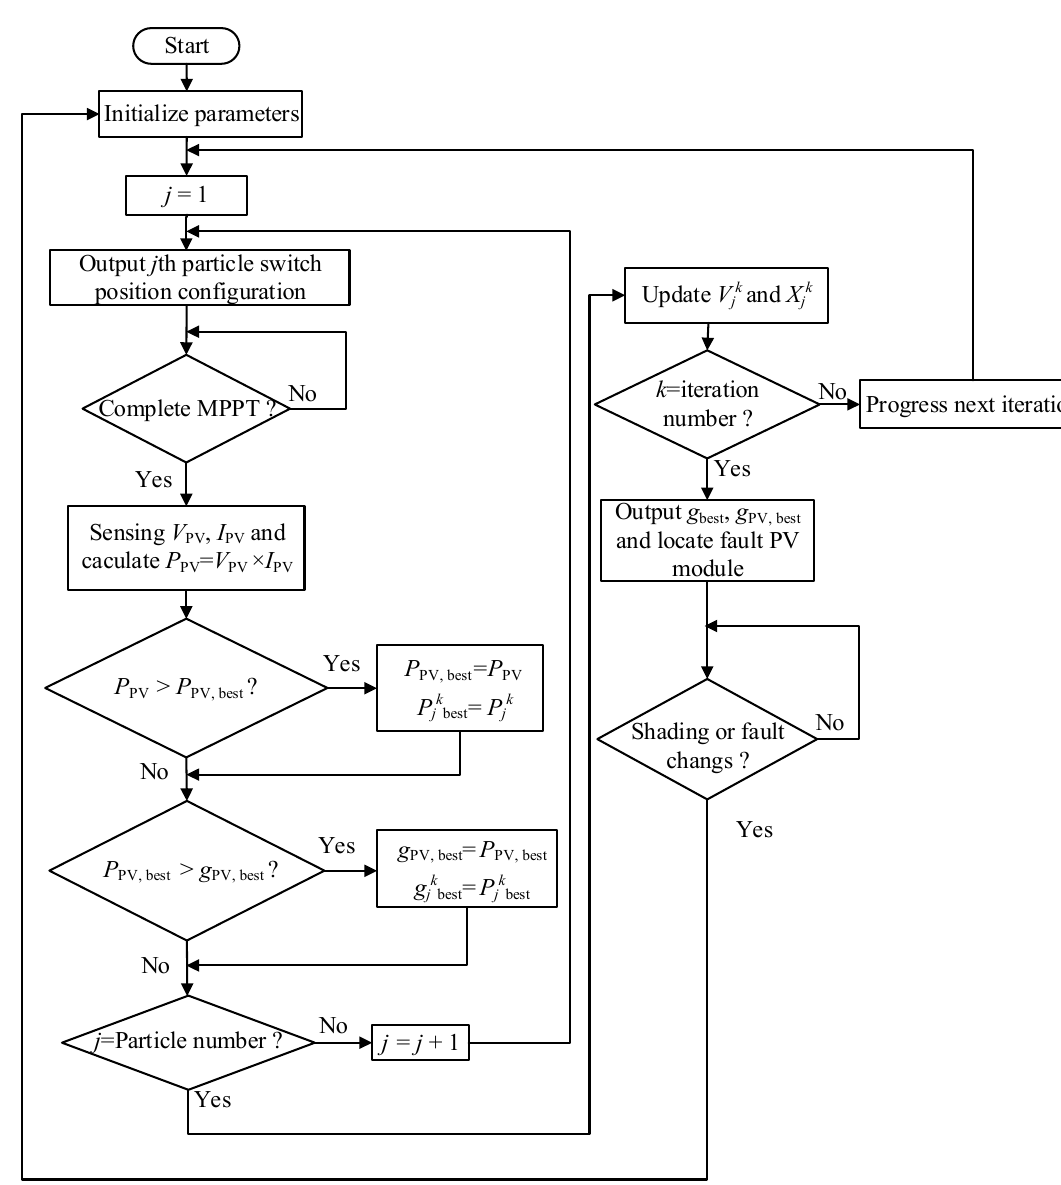
Figure 4. The flowchart of the configuration optimization using PSO for PV module array. In the algorithm of fault diagnosis, a particle represents the configuration of switch position in the Boolean variable. In Figure 1, the configuration of switch positions of S 2 , S 3 , S 6 , S 7 , S 10 , and S 11 is presented in Binary form 000000 ~ 111111. Therefore, there are 64 different switch position configurations. Here, 0 indicates that the switch is at the “OFF” state, and 1 indicates that the switch is at the “ON” state. Four particles are adopted in the algorithm of fault diagnosis in this paper each of which represents 16 switching states. For example, the first particle represents one of the position configurations 000000 ~ 001111, while the second particle represents another one of the position configurations 010000 ~ 011111, etc. However, in order to facilitate the iteration of a continuous variable in the iterative formula, the binary switch states are converted to a decimal value. As for the particles adopted in the maximum power tracking controller, they represent the output voltages of the PV module array or are equivalent to the duty cycles of the boost converter. This is also equivalent to the output voltage of the photovoltaic module array. Because the output voltage of the photovoltaic module can be controlled by changing the duty cycle of the boost converter, taking the duty cycle of each iteration to control the